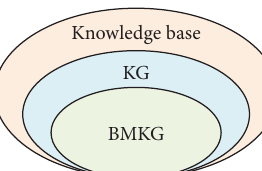
Figure 2: Te relationship between a knowledge base, a KG, and the BMKG.